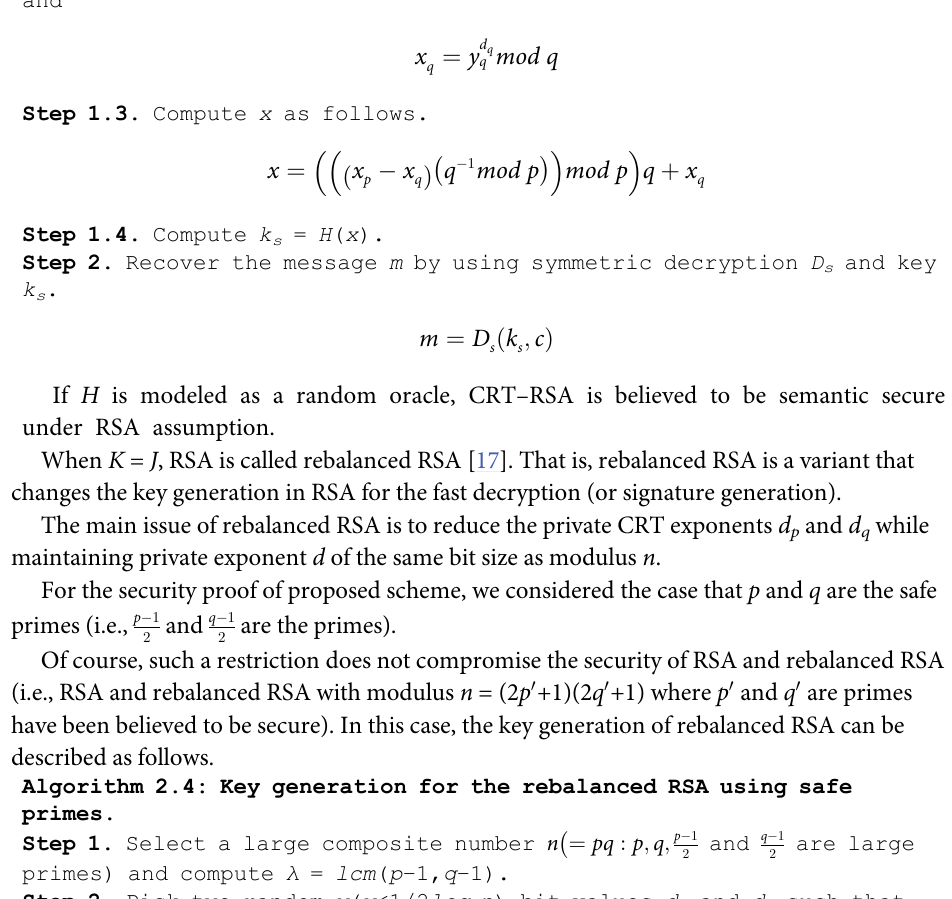
Algorithm 2.4: Key generation for the rebalanced RSA using safe primes